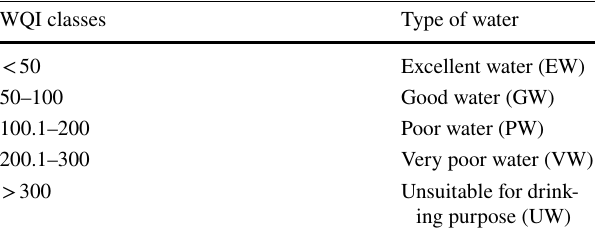
Table 2 Classification of WQI for drinking purpose in the study area WQI classes Type of